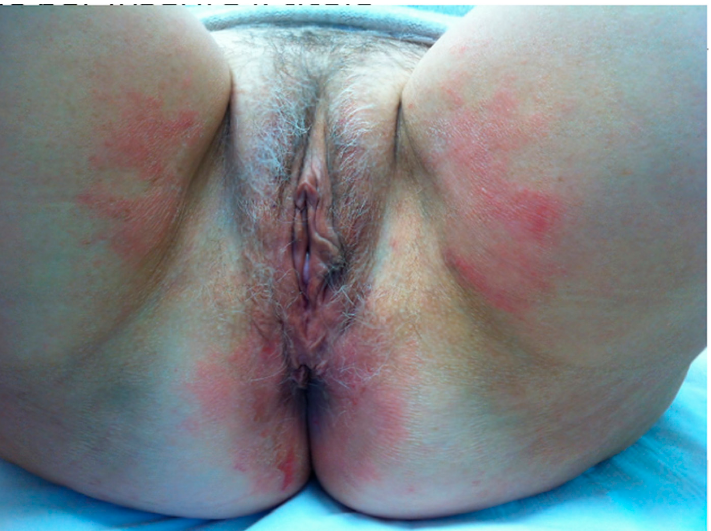
Figure 3. A case of allergic contact dermatitis in which the area of involvement spreads over the borders of the